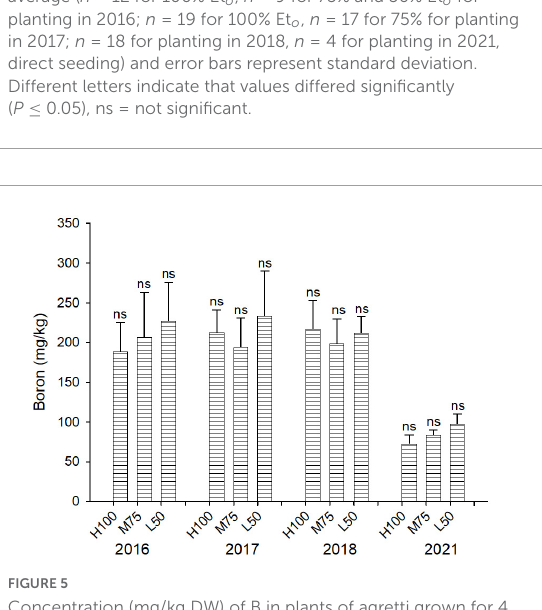
FIGURE3 Concentration (mg/kg DW) of Cl in plants of agretti grown for 4 years on saline, B- and Se-laden soil and irrigated at different rates (Et o %) with either low-saline water (2016 and 2017) or saline water (2018 and 2021). Statistical difference was performed to analyze the effect of irrigation levels within each planting year (H100 = high 100% Et o , M75 = medium 75% Et o , and L50 = low 50% Et o ) as described in Table 3 . Values represent average ( n = 12 for 100% Et o , n = 9 for 75% and 50% Et o for planting in 2016; n = 19 for 100% Et o , n = 17 for 75% for planting in 2017; n = 18 for planting in 2018, n = 4 for planting in 2021, direct seeding) and error bars represent standard deviation. Different letters indicate that values differed significantly ( P ≤ 0.05), ns = not significant.